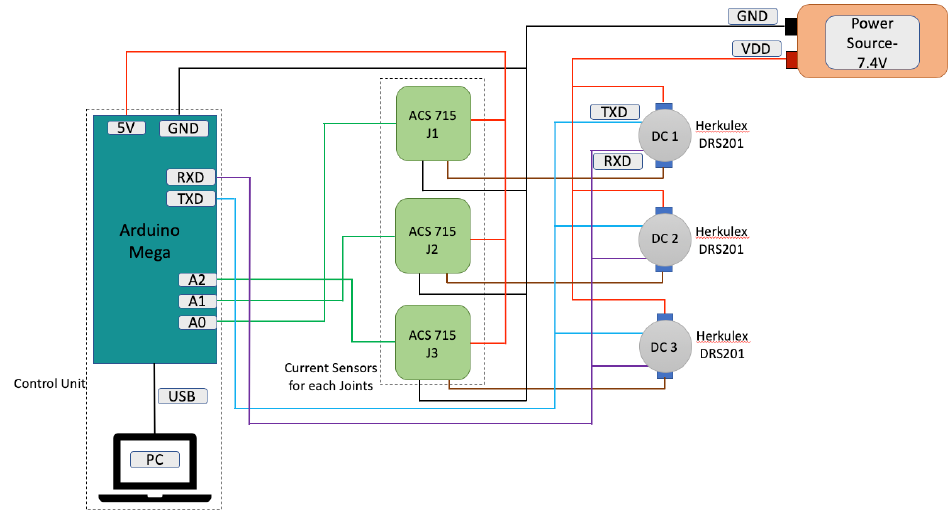
Figure 12. Electrical connection for the experimental set